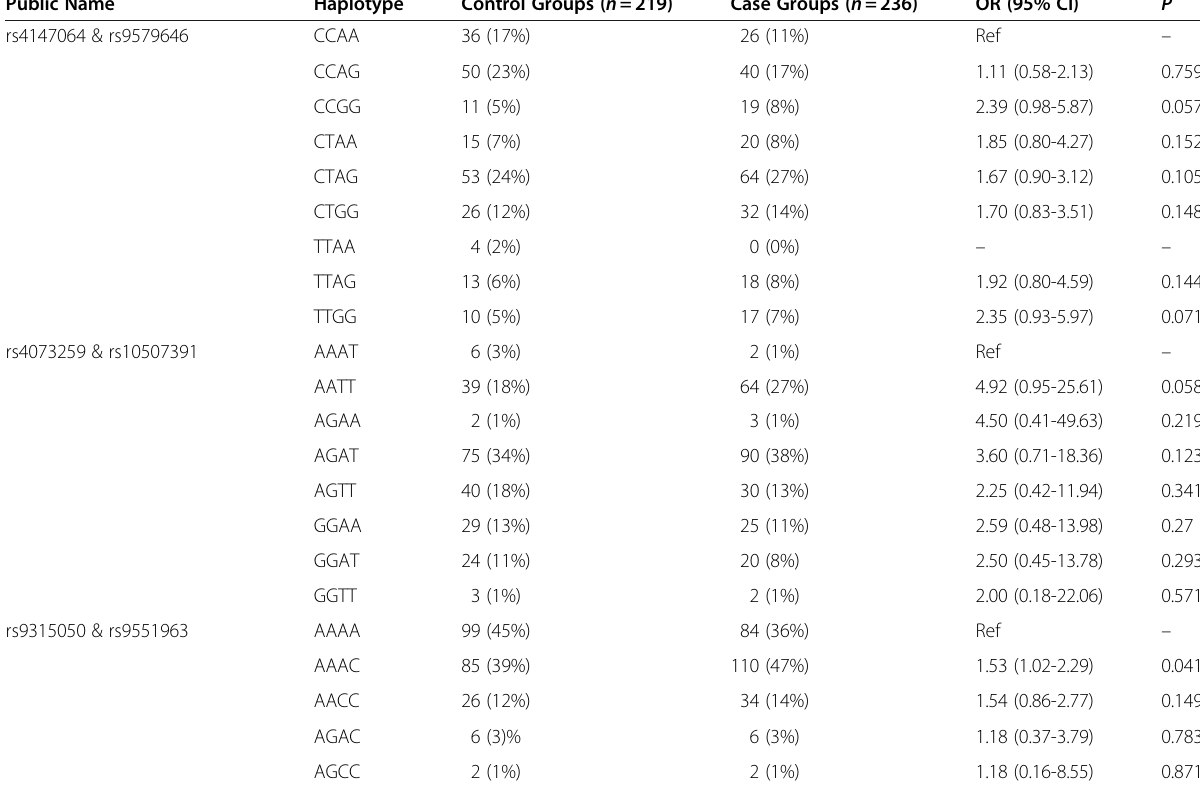
Table 5 Haplotype distribution in the stroke and control groups